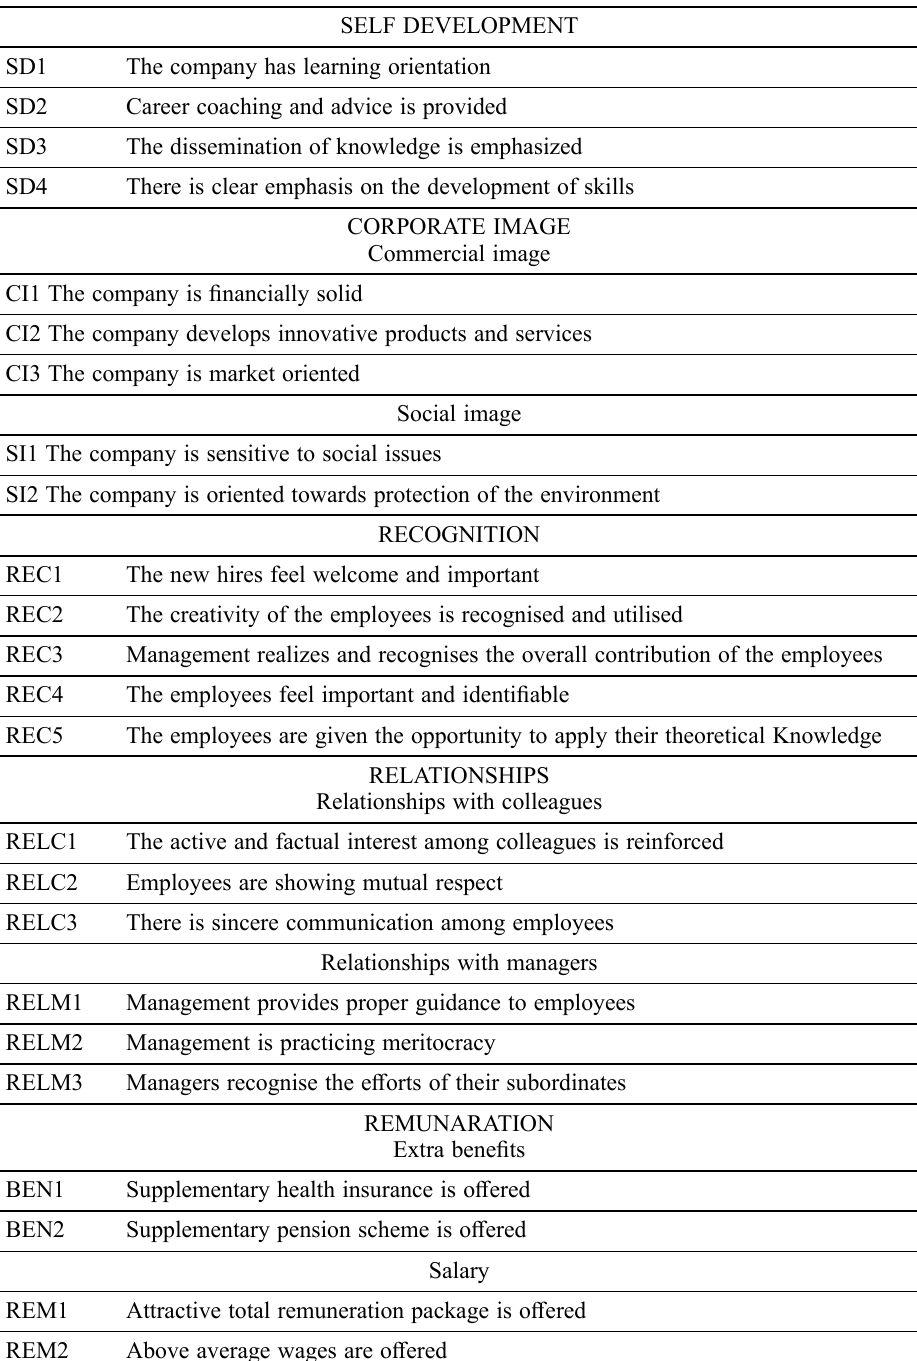
Table 4. EB of Choice – exact statements /